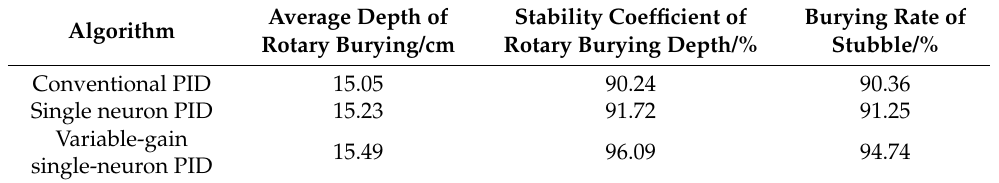
Table 3. Results of rotary burying of stubbles under three control algorithms in the field experiments.